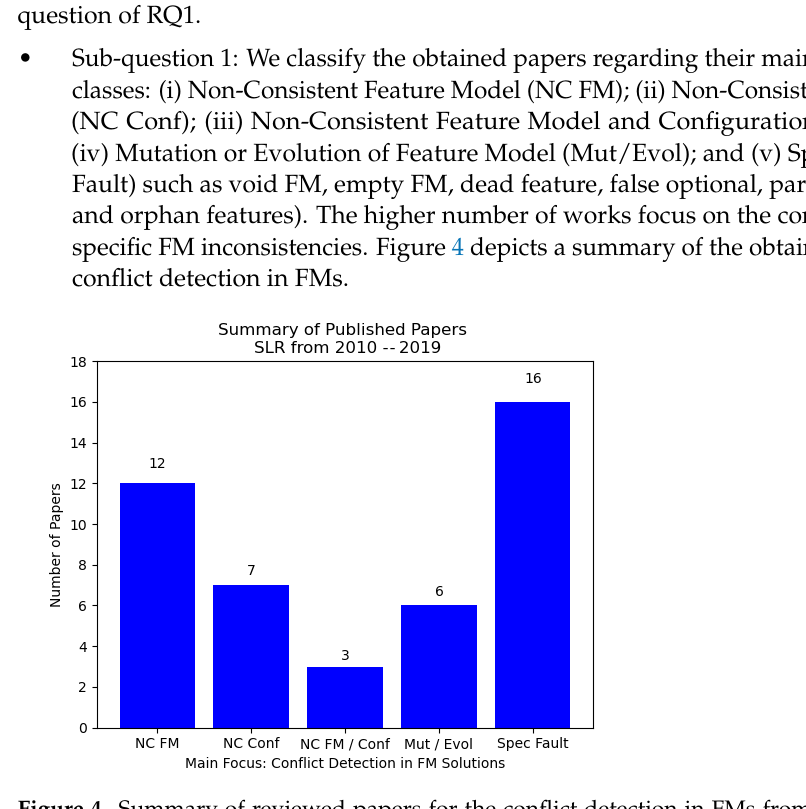
Figure 4. Summary of reviewed papers for the conflict detection in FMs from 2010 to August of August of